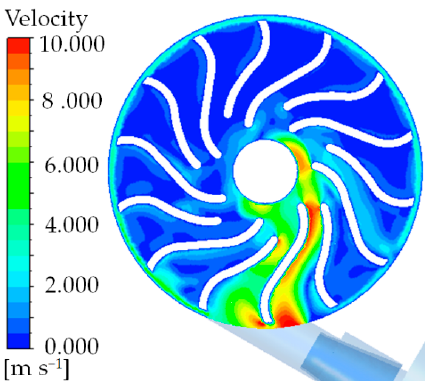
Figure 13. Velocity in the mid-span section of the runner.